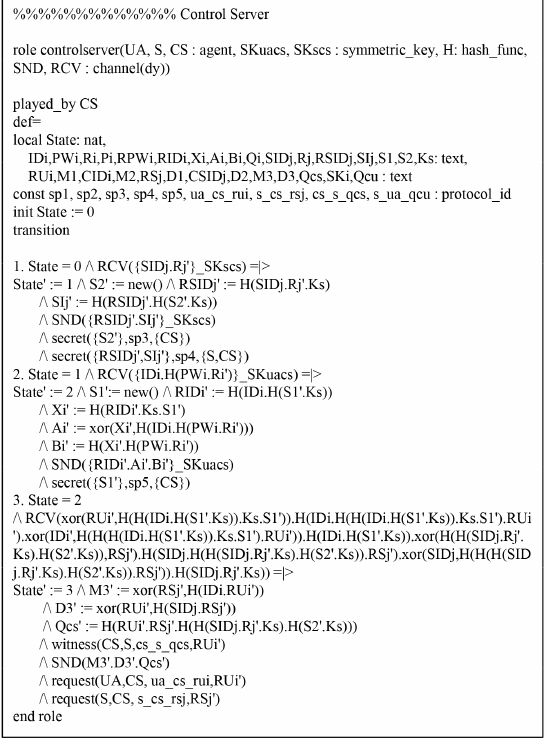
Figure 12. Role specification for control server CS .